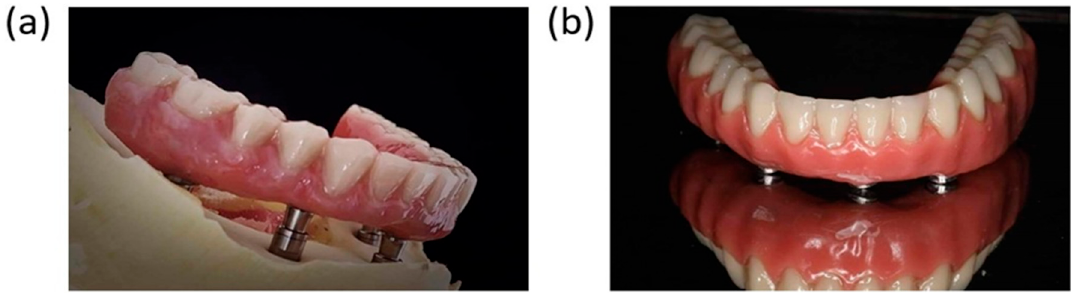
Figure 6. ( a ) Deformation when using three fences. ( b ) Deformation when using one fence.